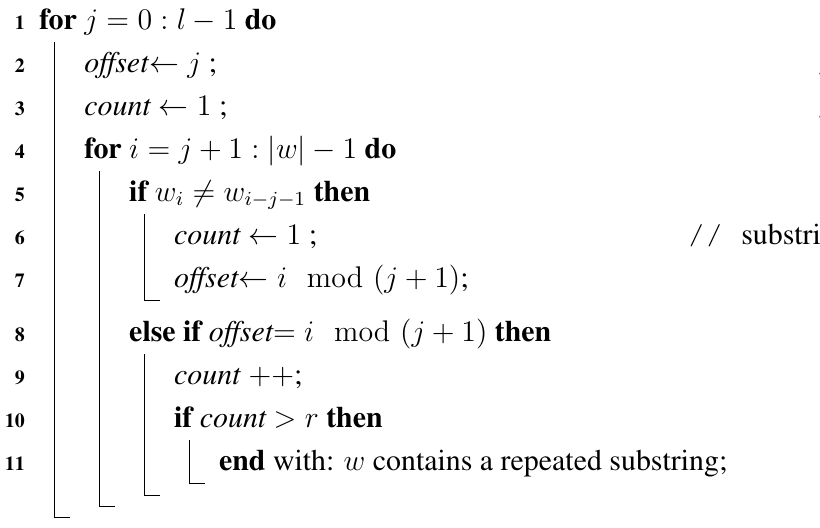
. . . w with repeat threshold 0 | w |− 1